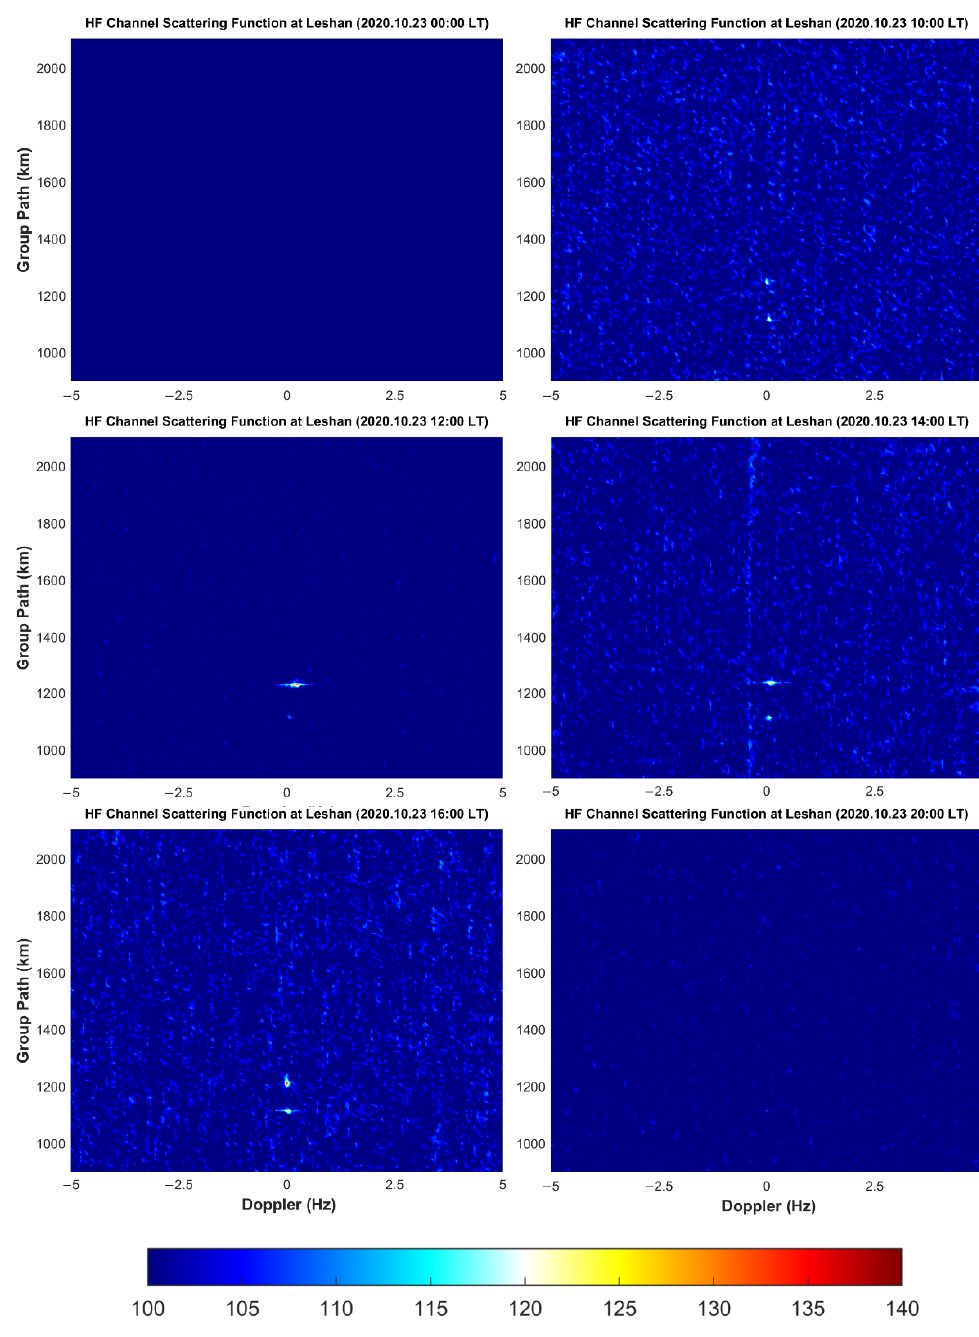
Figure 4. 23 October 2020, data processing results of Leshan station. Refer to the captions in Figure 2 for the receiving time and other descriptions of each panel.